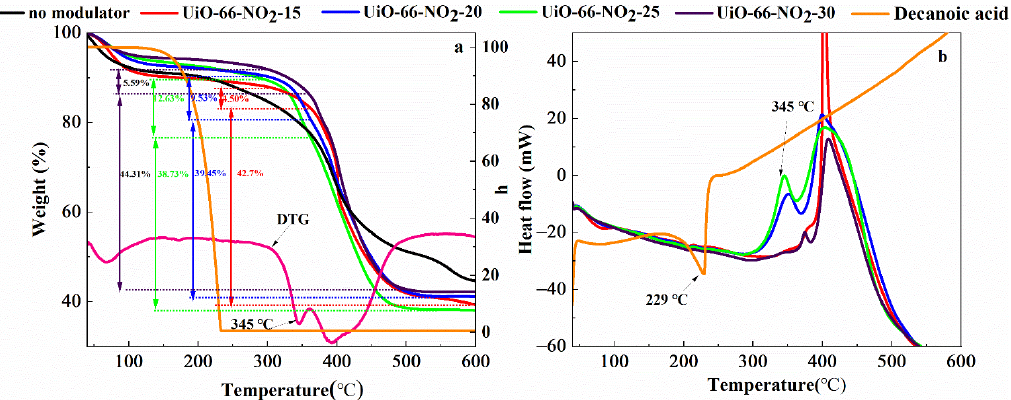
Figure 5. ( a ) TGA curves and ( b ) DSC curves of UiO − 66 − NO 2 − X. In ( a ) the DTG curve of UiO − 66 − NO 2 − 20 is shown in pink.